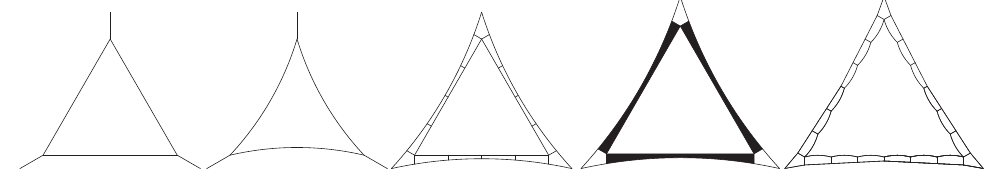
Figure 3. Five kinds of tensioned membrane schemes.